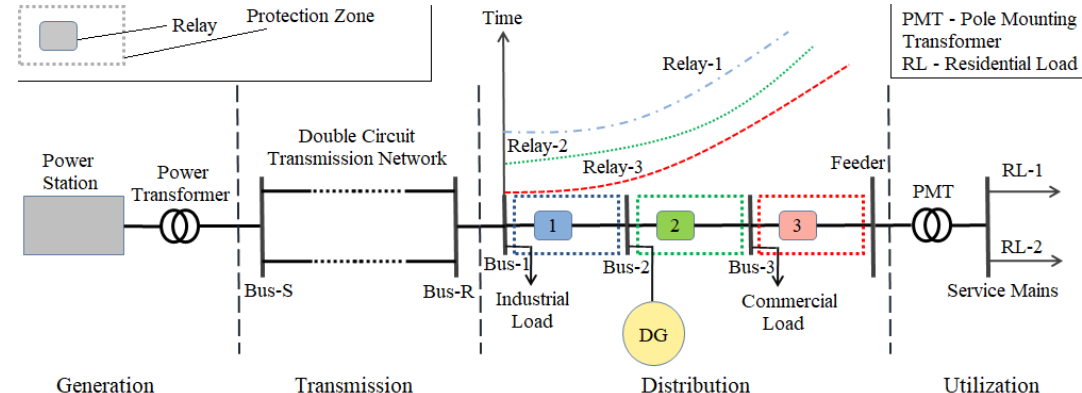
Figure 1. Power system architecture employing distributed generation with effective protection scheme against upstream and downstream faults. Time coordination among relays (blue, green and red) with dedicated protection zones is shown by associated characteristics curves providing primary and backup